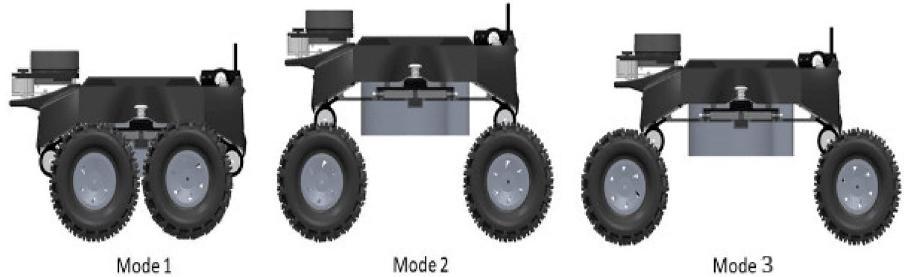
Figure 5. Raptor three different re-configuration modes.